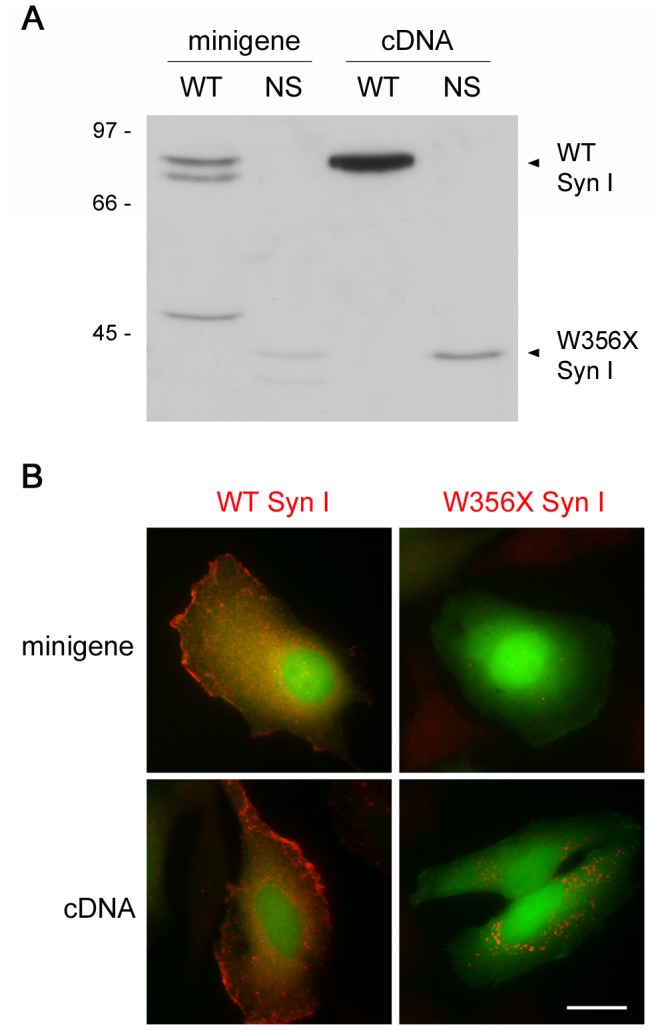
The W356× Syn I variant is poorly expressed in transfected HeLa cells.HeLa cells were transfected with either the complementary (cDNA) or genomic (minigene) DNA coding for either WT or W356× (NS) Syn I. A. Western blotting analysis shows that WT Syn I is efficiently expressed in both cDNA- and minigene-transfected cells (the two bands in the minigene-transfected sample corresponds to the Syn I a and b splicing isoforms). In contrast, the mutant protein is expressed with much lower efficiency in cDNA-transfected cells, and its levels are hardly detectable after transfection with the intron-containing minigene. B. Immunofluorescence images of HeLa cells co-transfected with pEGFP (in green) and either cDNAs or minigenes encoding either WT or mutant Syn I (anti-Syn I staining, in red). Immunostaining for mutant Syn I is appreciable in cells transfected with cDNA, but not with the minigene. Scale bar: 20 µm.